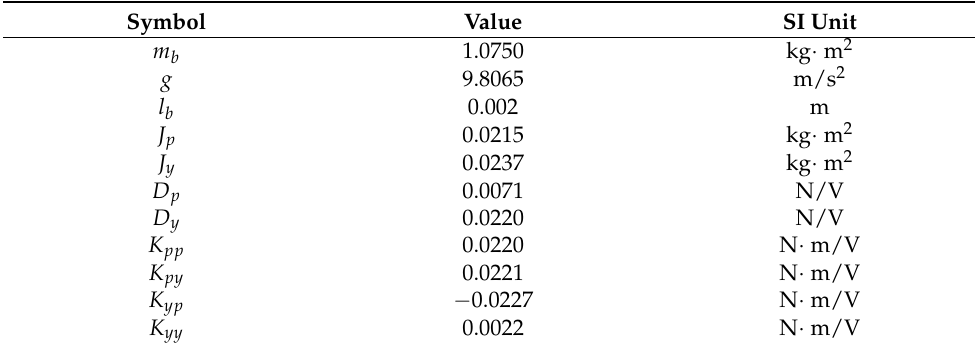
Table 1. Parameters of the 2-DOF Helicopter system